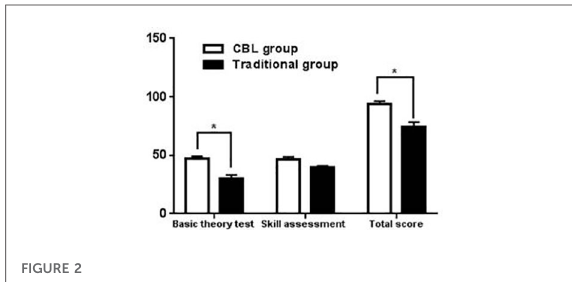
FIGURE 2 Average scores of basic theory test skill assessment and total score in the two groups.